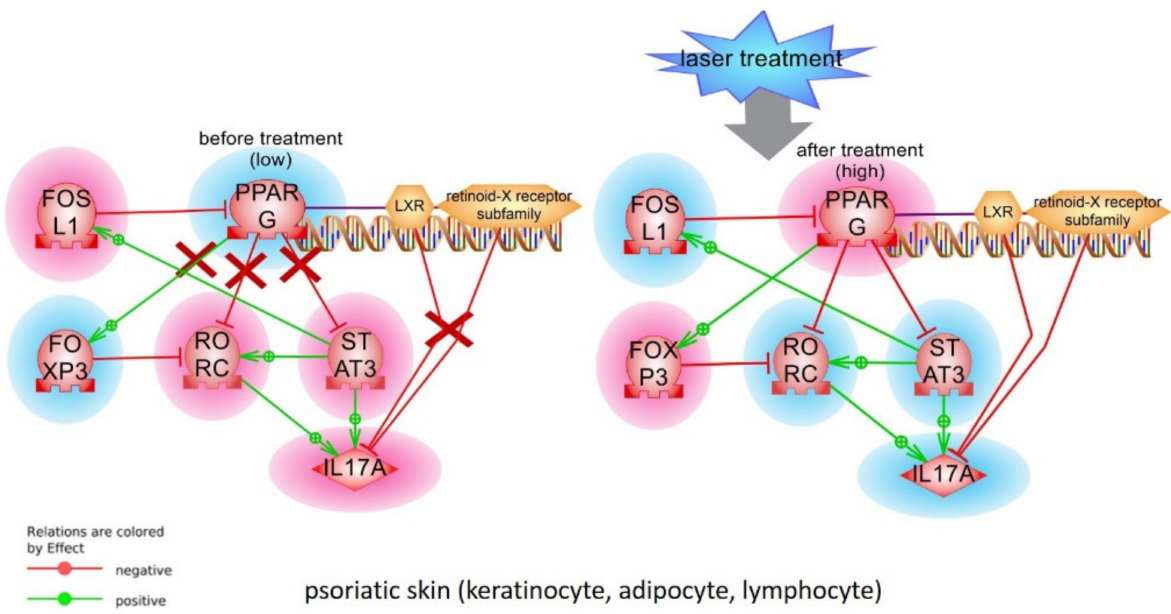
Figure 8. Alignment of tested changes in PPAR γ signaling before and after laser treatment with the model. Changes in gene expression after treatment are marked with highlights (red—elevated; blue—lowered). Red X symbolise non-functional protein-protein interactions. LXR-RXR complex activity was not